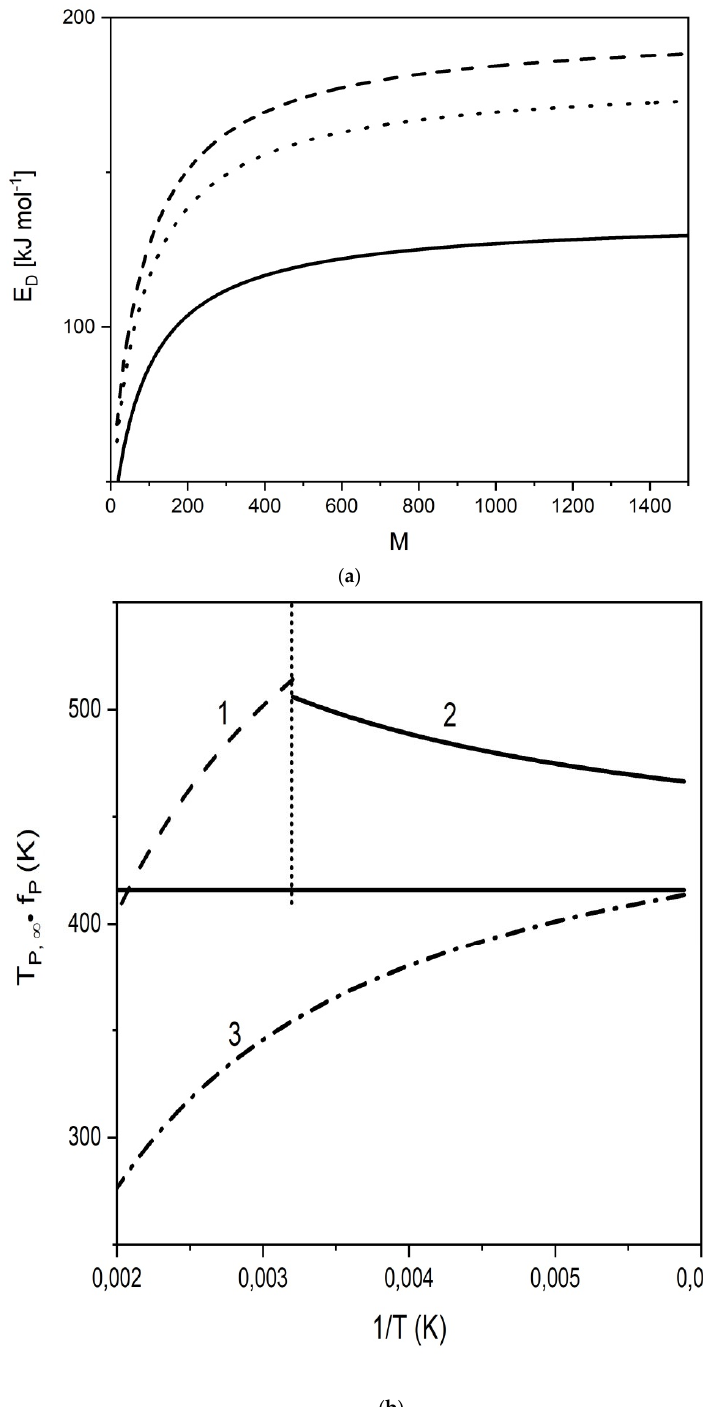
Figure 11. ( a ) Activation energy of diffusion in polymers as a function of the relative molecular mass M . ( — ) E D in HDPE with f HDPE ; (. . .) E D in thermoplastic PET; (- - -) E D in glassy PET with the corresponding f P -values from Equation (35). ( b ) The product T P, ∞ · f P from Equation (34) as function of 1/ T . ( — ) T P, ∞ · 1; (3) T P, ∞ · f HDPE from Equation (35); (1) T P, ∞ · f t , PET ; (2) T P, ∞ · f g , PET from Equation